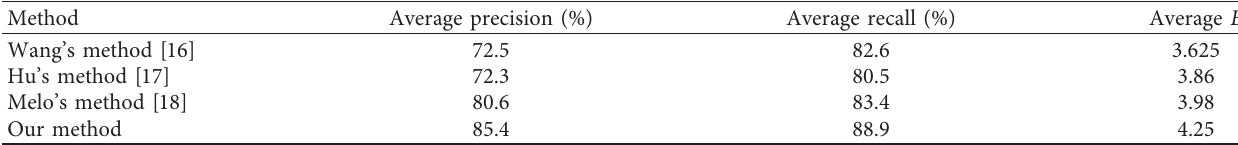
Table 1: Experiment result of different methods.